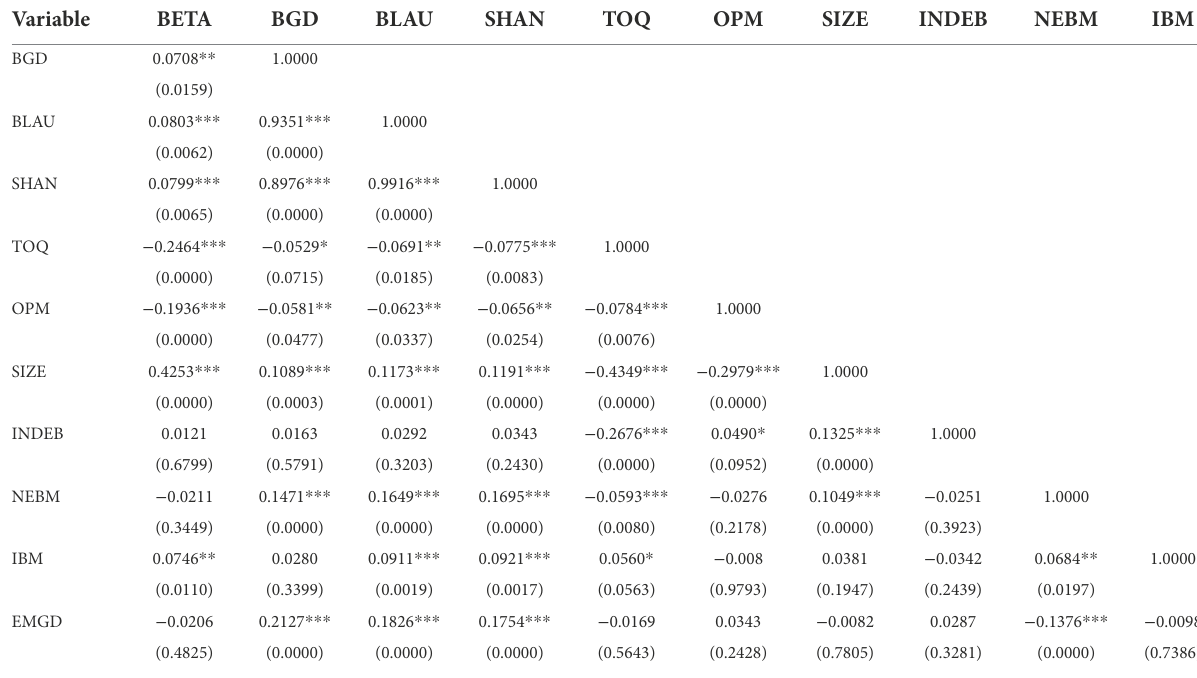
TABLE 6 Pearson correlations between continuous variables in the EU market.